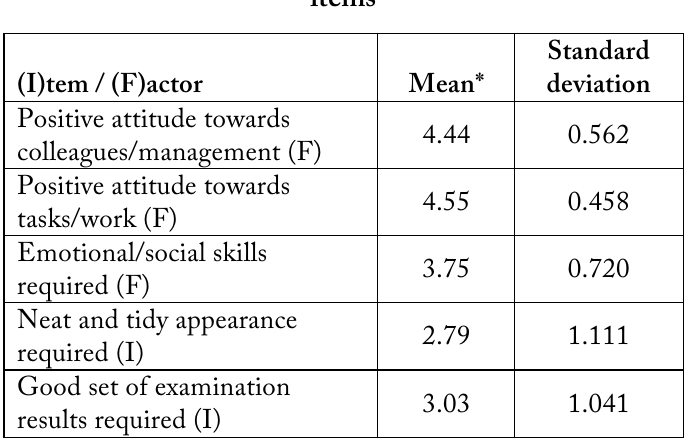
Table 3: Basic analysis of new graduate factors and